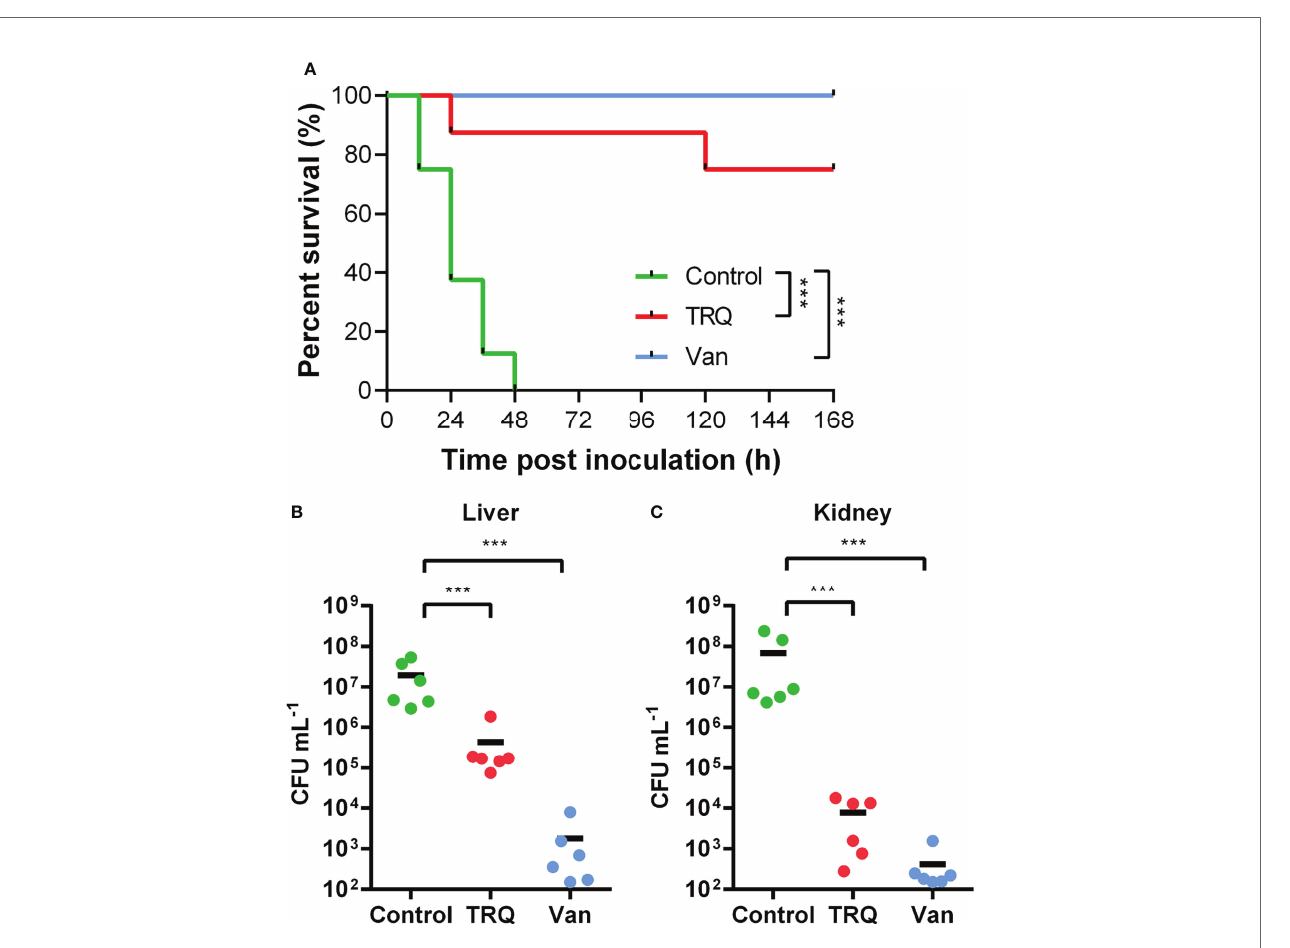
FIGURE 4 | TRQ attenuates S. aureus virulence in a murine infection model. The control, TRQ-treated bacteria (TRQ, 1/16 dilution), and vancomycin-treated bacteria (Van) were used to infect 6 mice via intravenous injection. (A) Effect of TRQ in protecting mice (n=6) from lethal S. aureus infection. *** P < 0.001; log-rank test. After 7 d post-infection, S. aureus colonization in murine liver (B) or kidney (C) was enumerated. Each circle represents one mouse. The horizontal black line represents the mean log 10 CFU on the y axis. The statistical difference between control and TRQ-treated group or control and vancomycin-treated group was determined using Student ’ s t -test. *** P <